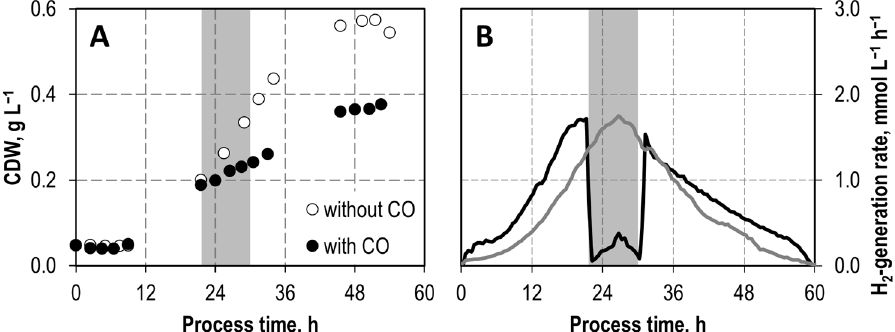
Figure 3. Batch cultivations of C. kluyveri in fully controlled stirred-tank bioreactors without CO in the inlet gas (open circles, grey line) and with gassing of 100 mbar CO indicated by the grey shaded area over a period of 9 h (black). ( A ) Cell dry weight concentrations (CDW); ( B ) Hydrogen-generation rate (T = 37 °C; pH = 6.0; P V − 1 = 10.5 W L − 1 ; F gas = 0.042 vvm with 200 mbar CO 2 ).